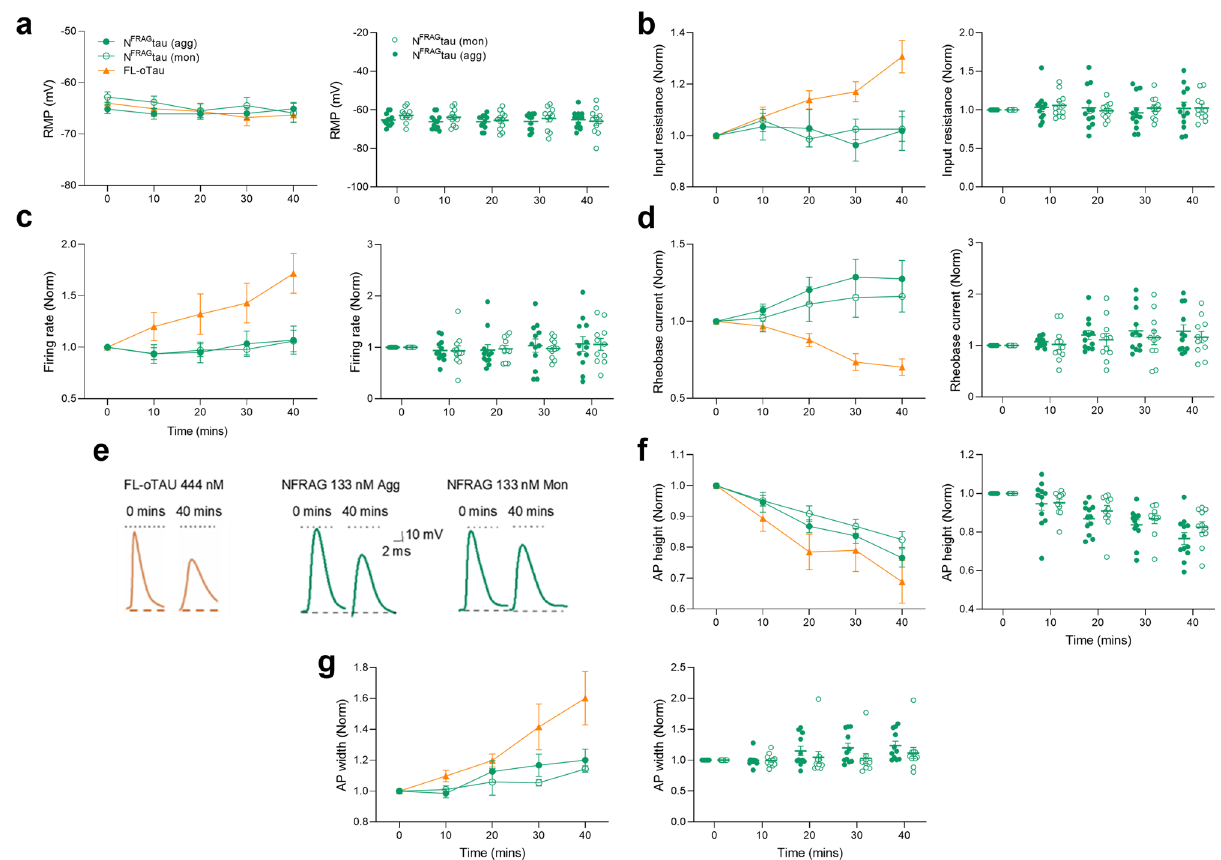
Fig. 6 The effects of FL-oTau on action-potential waveform are reproduced by lower concentrations of N FRAG -tau aggregates and monomers. a – d , f and g display both average data (mean ± SEM) as well as individual data points for each condition over time. a Graph showing that there is no change to the resting membrane potential over the period of recording for any of the conditions (133 nM N FRAG -tau monomers or aggregates; N FRAG -tau aggregates: at 40 min, the resting membrane potential was 99 ± 1.0% of that at time 0, P = 0.9609, n = 12 cells, seven animals; N FRAG -tau monomers at 40 min, the resting membrane potential was 104 ± 2.4% of that at time 0, P = 0.0938, n = 12 cells, six animals. b Graph showing that there is no change to the input resistance over the period of recording for 133 nM N FRAG -tau aggregates or monomers (N FRAG -tau aggregates: at 40 min, the peak input resistance, measured from the voltage response to step current injection, was 102 ± 7.7% of that at time 0, P = 0.9531; N FRAG -tau monomers: at 40 min, the peak input resistance, measured from the voltage response to step current injection, was 102 ± 4.1% of that at time 0, P = 0.9395. c Graph showing that there is no change to the fi ring rate over the period of recording for 133 nM N FRAG aggregates or monomers (N FRAG -tau aggregates: at 40 min, the fi ring rate, measured from the voltage response to naturalistic current injection, was 107 ± 13.6% of that at time 0, P = 0.7471; N FRAG -tau monomers: at 40 min, the fi ring rate, measured from the voltage response to naturalistic current injection, was 106 ± 10.5% of that at time 0, P = 0.5068). d Graph showing that there is no change to the rheobase current (minimal current to evoke an AP) over the period of recording for 133 nM N FRAG -tau aggregates or monomers (N FRAG -tau aggregates: at 40 min, the rheobase was 127 ± 11.9% of that at time 0, P = 0.1294; N FRAG -tau monomers: at 40 min, the rheobase was 116 ± 10.1% of that at time 0, P = 0.2402). e Representative examples of average action-potential waveforms from neurons with either 444 nM FL-oTau, 133 nM N FRAG -tau aggregates or 133 nM N FRAG -tau monomers introduced. In all three conditions, there is a comparable decrease in action-potential height and increase in action-potential width. f Graph plotting mean normalised action-potential height (at time 0) against time. There is a comparable decrease in action-potential height for 133 nM N FRAG -tau aggregates, monomers and FL-oTau (N FRAG -tau aggregates: action-potential amplitude at 40 min was signi fi cantly reduced to 76 ± 2.9% of that at time 0 min, P = 0.0005; N FRAG -tau monomers: action-potential amplitude at 40 min was signi fi cantly reduced to 82 ± 2.6% of that at time 0 min, P = 0.0010). g Graph plotting mean normalised action-potential width (at time 0) against time. There is a comparable increase in action-potential width over the period of recording for 133 nM N FRAG -tau aggregates, monomers and FL-oTau (N FRAG -tau aggregates: action- potential width at 40 min was signi fi cantly increased to 118 ± 7.4% of that at time 0 min, P = 0.0186; N FRAG -tau 32 monomers: action-potential width at 40 min was signi fi cantly increased to 123 ± 2.0 % of that at time 0 min, P = 0.0303). Orange lines demonstrate the effects of FL-oTau for comparison (data presented in Fig. 2). AP action potential, FR fi ring rate, Rin input resistance, resting membrane potential, resting membrane potential). Error bars represent the standard error of the mean